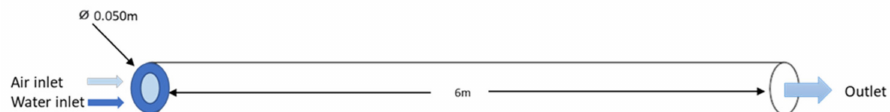
Figure 1. Pipe geometry.